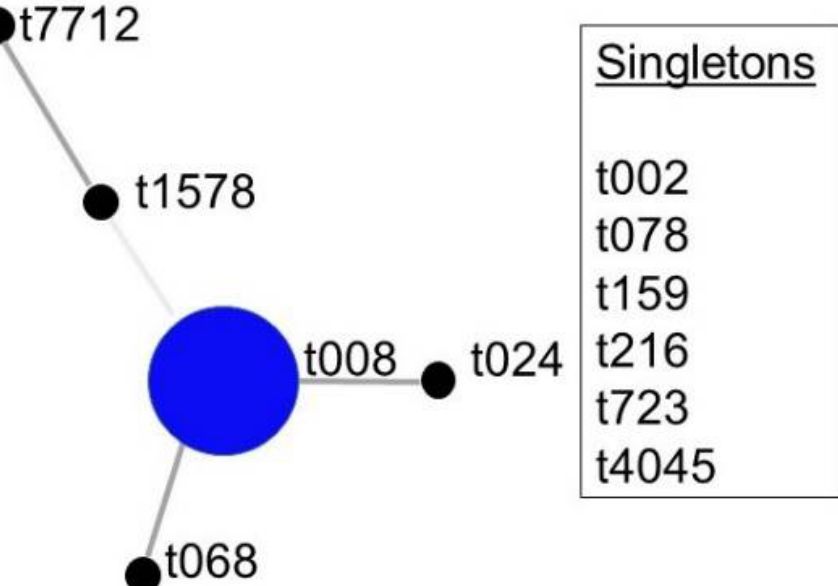
Figure 1. Based upon repeat pattern (BURP) analysis of the 11 spa types, spa -CC t008 was the major clonal complex and there were six singletons.